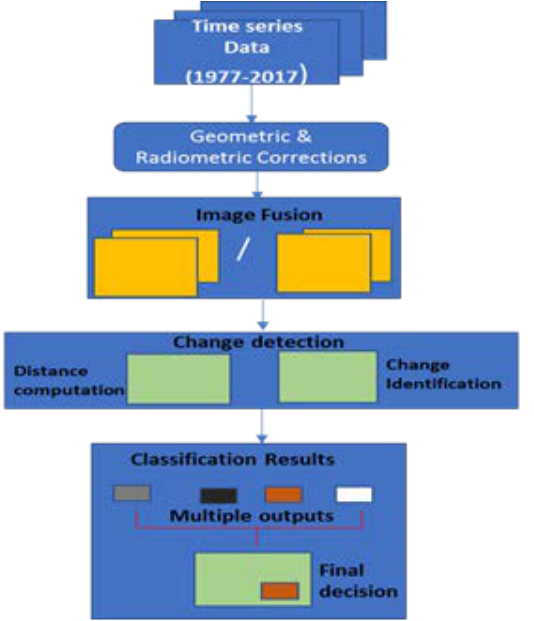
Figure 2 : Workflow of the proposed supervised change detection algorithm.